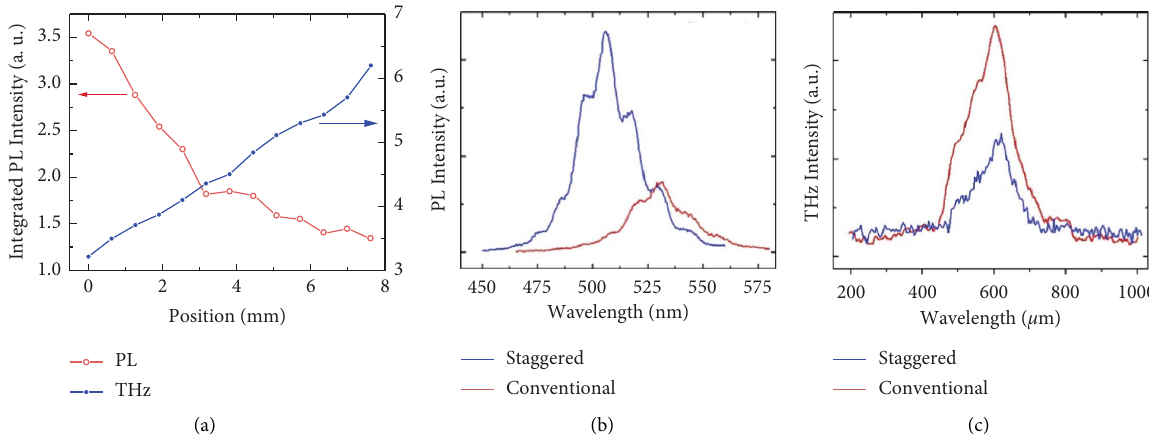
Figure 7: (a) Integrated PL intensity and average THz output powers. 0 and 8 in the horizontal axis represent the center and edge of the multiple QWs, respectively. (b) Comparison of PL and (c) THz spectra of staggered and conventional InGaN QWs. Copyright Optica publishing